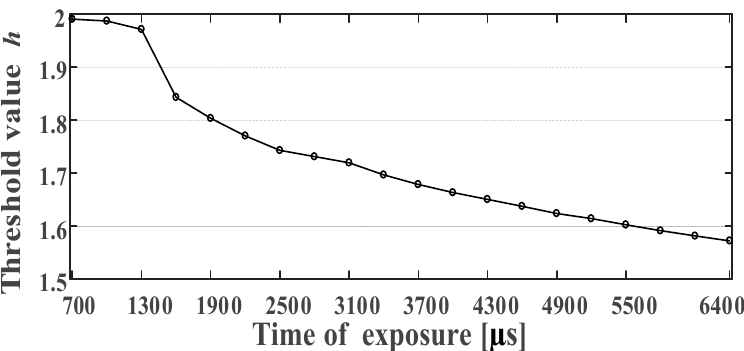
Figure 6. The relationship between the threshold h and the light source intensity.